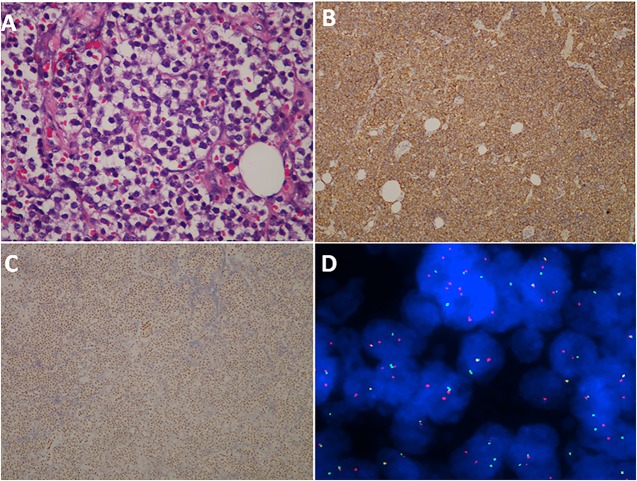
Histopathological, immunohistochemical, and cytogenetic examination of ES/pPNET. Light microscopy showed a highly cellular ES/pPNET tumor consisting of undifferentiated, small, round cells with frequent mitoses (A) (hematoxylin–eosin × 400). Immunohistochemical staining showed positivity for CD99 (×100) (B). Microphotograph showing immunohistochemical staining of FLI-1 (C). The representative FISH result using EWSR1 (22q12) dual color break apart rearrangement probe (Vysis). Tumor cells of the ES/pPNET displayed one fusion (yellow signal), and the simultaneous split pattern of one orange and one green signal, being indicative of a rearrangement of one copy of the EWSR1 gene (D).